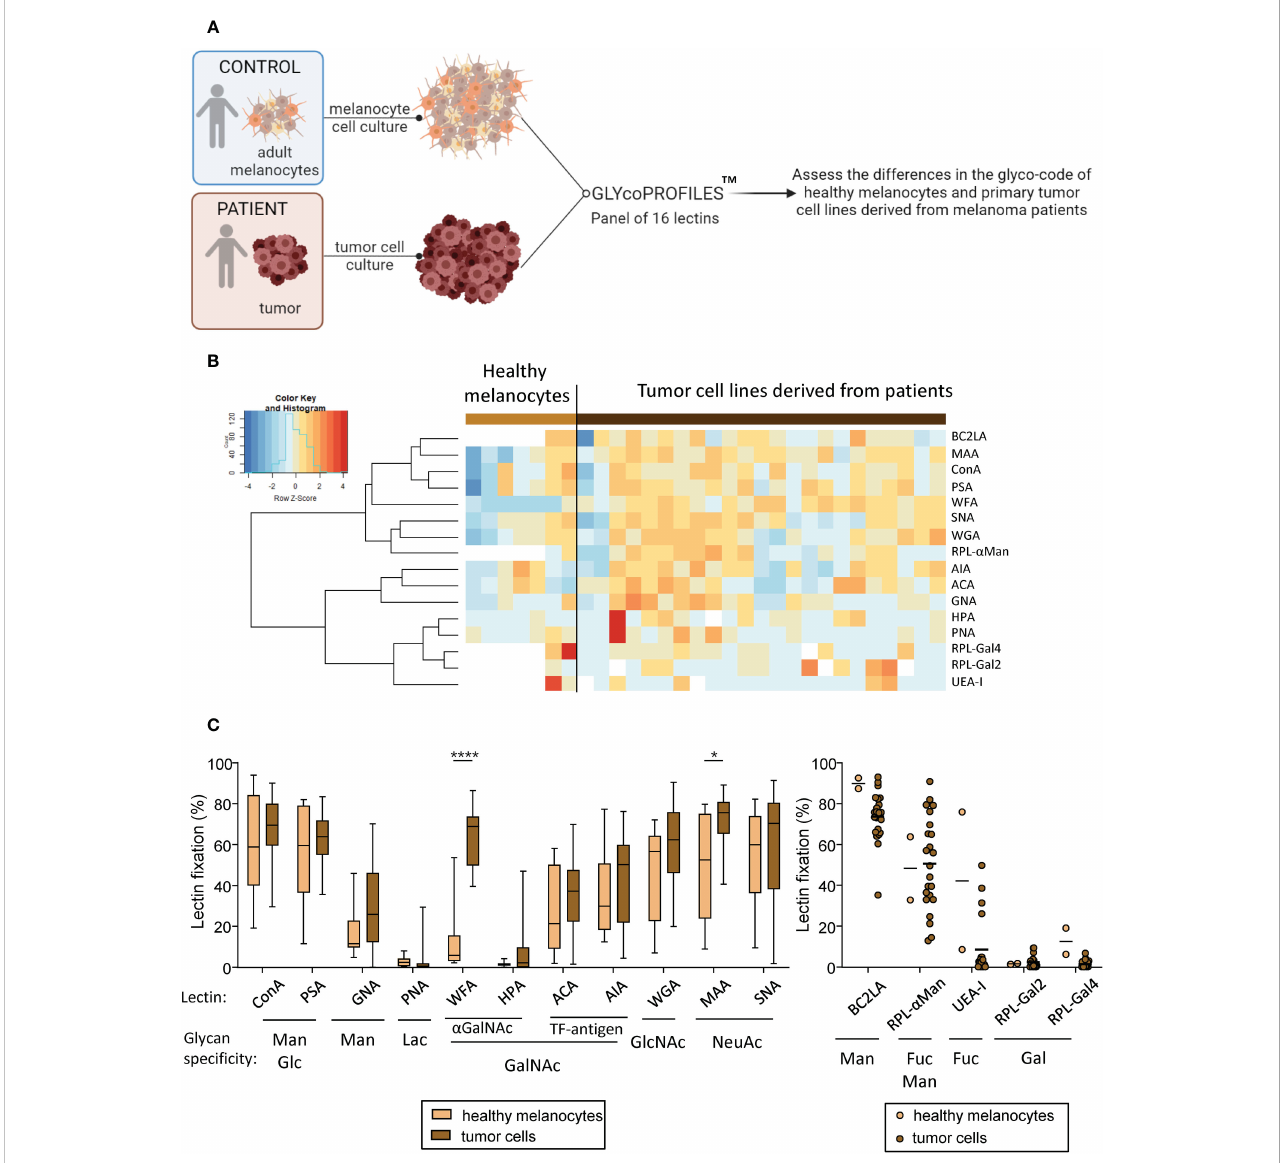
FIGURE 2 Primary tumor cells derived from melanoma patients display differences in their glyco-code when compared to healthy melanocytes. GLYcoPROFILE ™ (lectin arrays from GLYcoDiag) were performed on human adult melanocytes and tumor cell lines derived from melanoma patients. (A) Schematic representation of the experimental layout to depict the glyco-code of adult melanocytes and tumor cell lines derived from melanoma patients. (B) Heat map based on frequencies of 16 different lectins interaction (binding different glycans) on healthy melanocytes (n = 2 to 6; depending on the lectin studied) and tumor cell lines derived from melanoma patients (n = 23). (C) Levels of lectin interaction (indicators of levels of glycan expression) of ConA, PSA, GNA, PNA, WFA, HPA, ACA, AIA, WGA, MAA and SNA (left panel) by healthy melanocytes (light brown; n = 6) and tumor cells (dark brown; n =23). Results are expressed as percentages of lectin binding within each group. Interleaved box and whiskers representation plotting from minimum to maximum. Only signi fi cant statistics are shown on the graphs. P -values were calculated using two-way ANOVA with Bonferroni ’ s multiple comparisons test. *P-value ≤ 0.05, ****P-value ≤ 0.0001. The levels of lectin fi xation of BC2LA, RPL- a Man, UEA-I, RPL-Gal2 and RPL-Gal4 (right panel) on healthy melanocytes (n=2) and tumor cell lines (n=23) are illustrated using a scatter dot plot